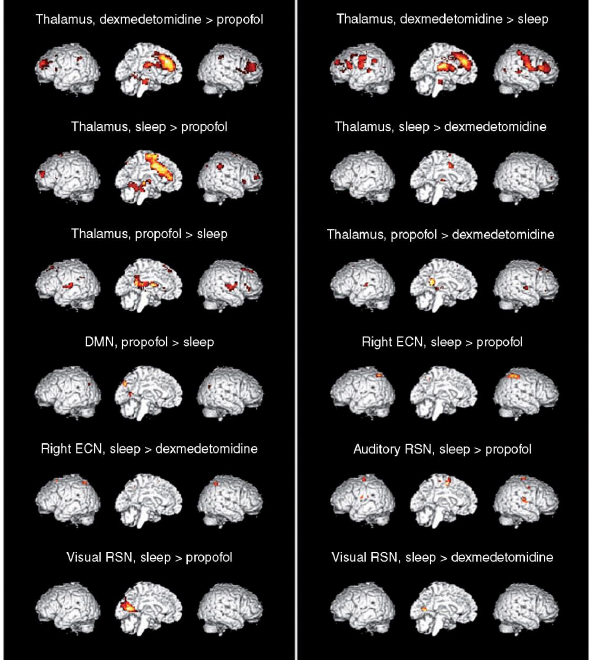
Figure 4. Contrast images showing regions where functional connectivity is higher during dexmedetomidine- than propofol-induced unresponsiveness (dexmedetomidine > propofol), dexmedetomidine than N3 sleep (dexmedetomidine > sleep), N3 sleep than propofol (sleep > propofol), N3 sleep than dexmedetomidine (sleep > dexmedetomidine), propofol than N3 sleep (propofol > sleep), or propofol than dexmedetomidine (propofol > dexmedetomidine). Only those contrasts where significant differences (false discovery rate-corrected p < 0.05) were found are shown, as was the case for connectivity with the thalamus (thalamus), within the default mode network (DMN), the right executive control network (right ECN), the auditory network (auditory resting state network RSN (Auditory resting state network)), and the visual network (visual RSN). Contrast images are superimposed on a canonical three-dimensional brain representation providing a left, right, and sagittal view of the brain. A left or right view of the internal face of the brain was chosen as a function of the presence of significant clusters or not. When no significant clusters were visible on one view, the other one was chosen [15]. DEX in adult volunteers (1 mcg/kg bolus then 0.7 mcg/kg/h) has been shown to reduce mean strength of cortical networks without impairing degree of distributions, while still modulating functional connectivity within and between all resting networks [42]. DEX sedation, unlike propofol, has been shown to partially preserve processing of words in adult volunteers [43]. Similar studies evaluating the EEGs across the specific cortical areas have to date not been specifically performed in the pediatric population. However, important adult studies may provide ideas for future pediatric investigations.